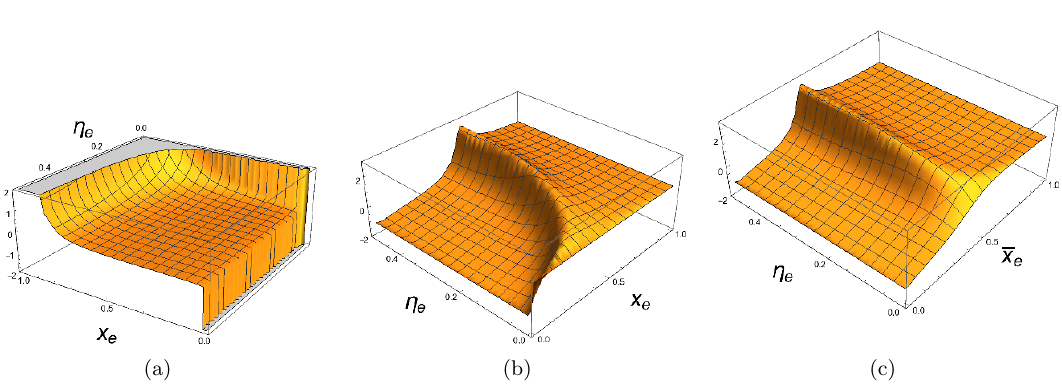
Figure 20 . (a) The original function f ( x e ; y e ) of (D.1), which diverges in various limits; (b) the corresponding (cid:12)nite function g of (D.10); (c) a smoothed version of g created by transforming x e to (cid:22) x e as in